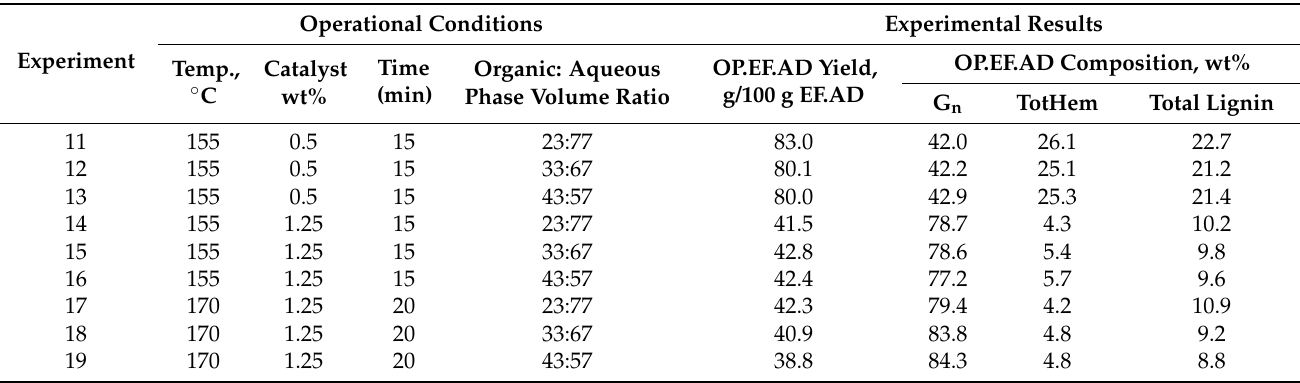
Table 3. Operational conditions considered for EF.AD fractionation and results achieved, operating at a liquid to solid ratio of 15 mL/g.